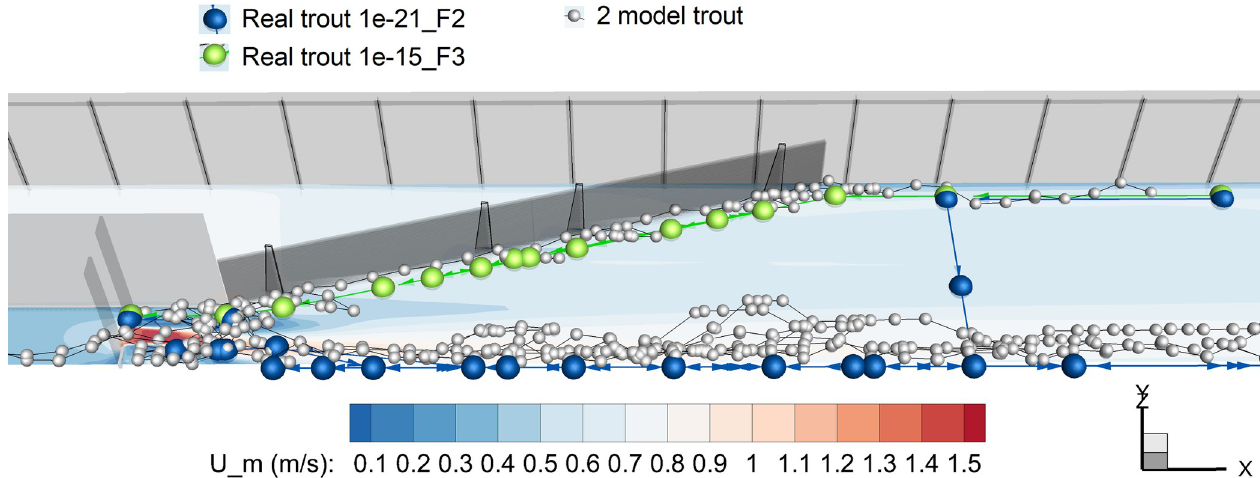
Fig 6. Two selected real and two selected model trout tracks in setup 1 (with jet). Each sphere shows one noted position or model time step, respectively. Model results are from the best parameter set of the wall distance stimulus. Plane shows mean velocity, U from left to right, fish start from right on both flume sides. See S1 and S2 Appendices for observed trout movement data.